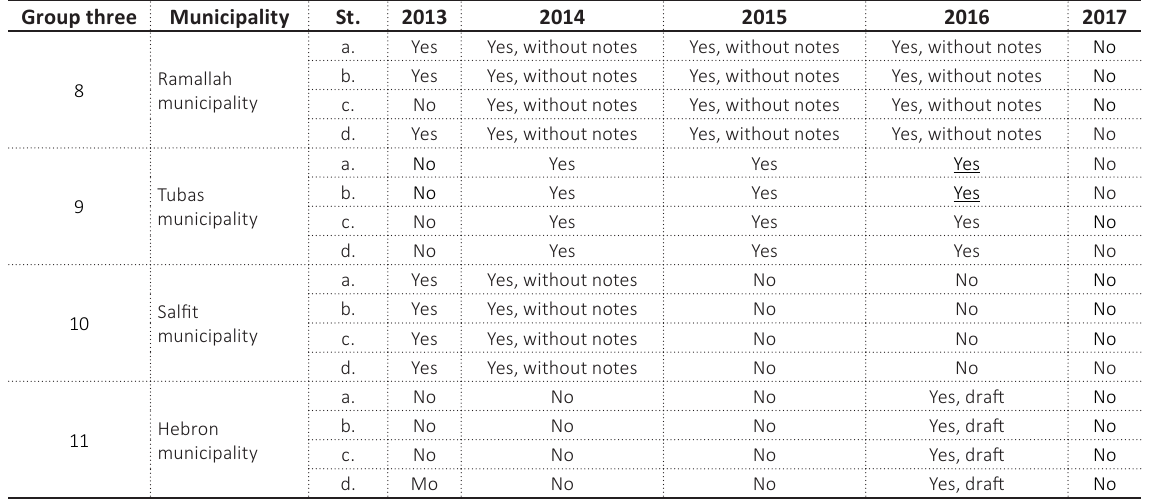
Table 15. Final analysis of macroeconomic and status variables 1. Final